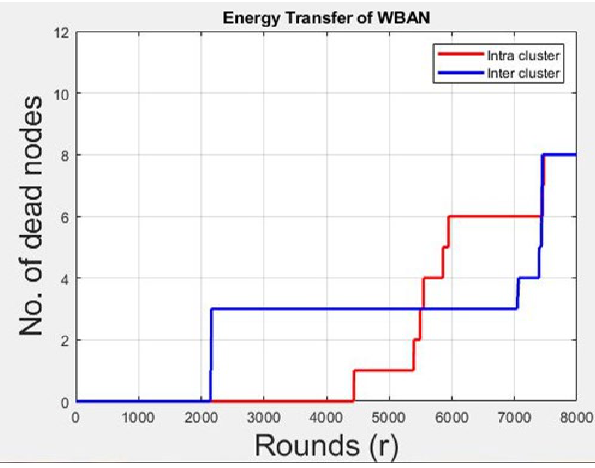
Figure 7. Energy Transfer for